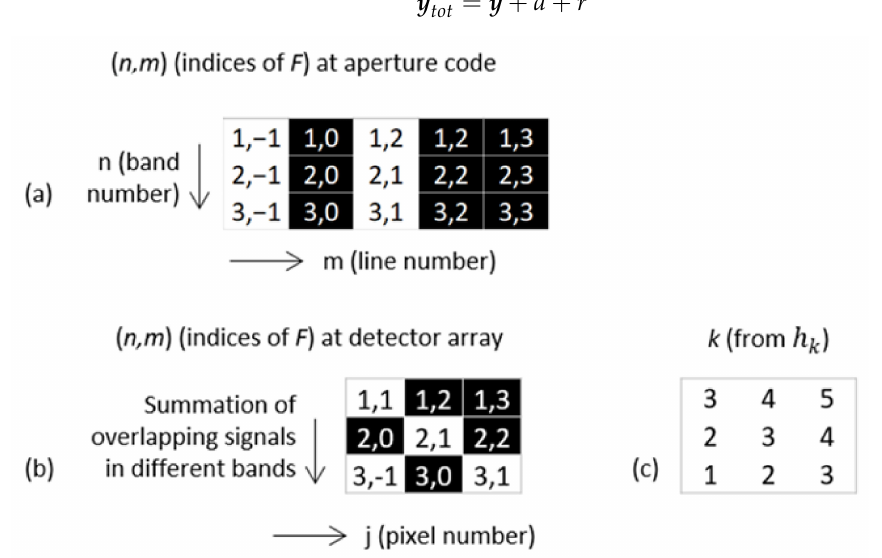
Figure 5. ( a ) table illustrating a portion of F , showing the indices of each element, with shading to represent an aperture code. The same element of the aperture code is applied to every band from a particular spatial location. ( b ) table illustrating the spatial arrangement of different elements of F after spectral dispersion. Again, shading indicates the pattern of aperture coding applied. The sum of each column (with the value of F multiplied by the aperture code) gives the signal at detector element j . ( c ) illustrates which element of the aperture code is applicable to each element in ( b